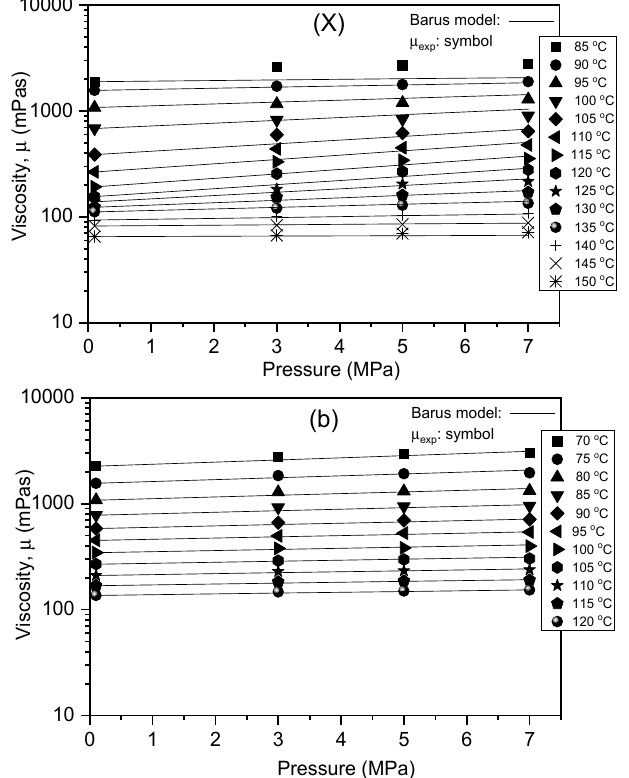
Figure 5. Experimental and calculated viscosities using Equation (2).